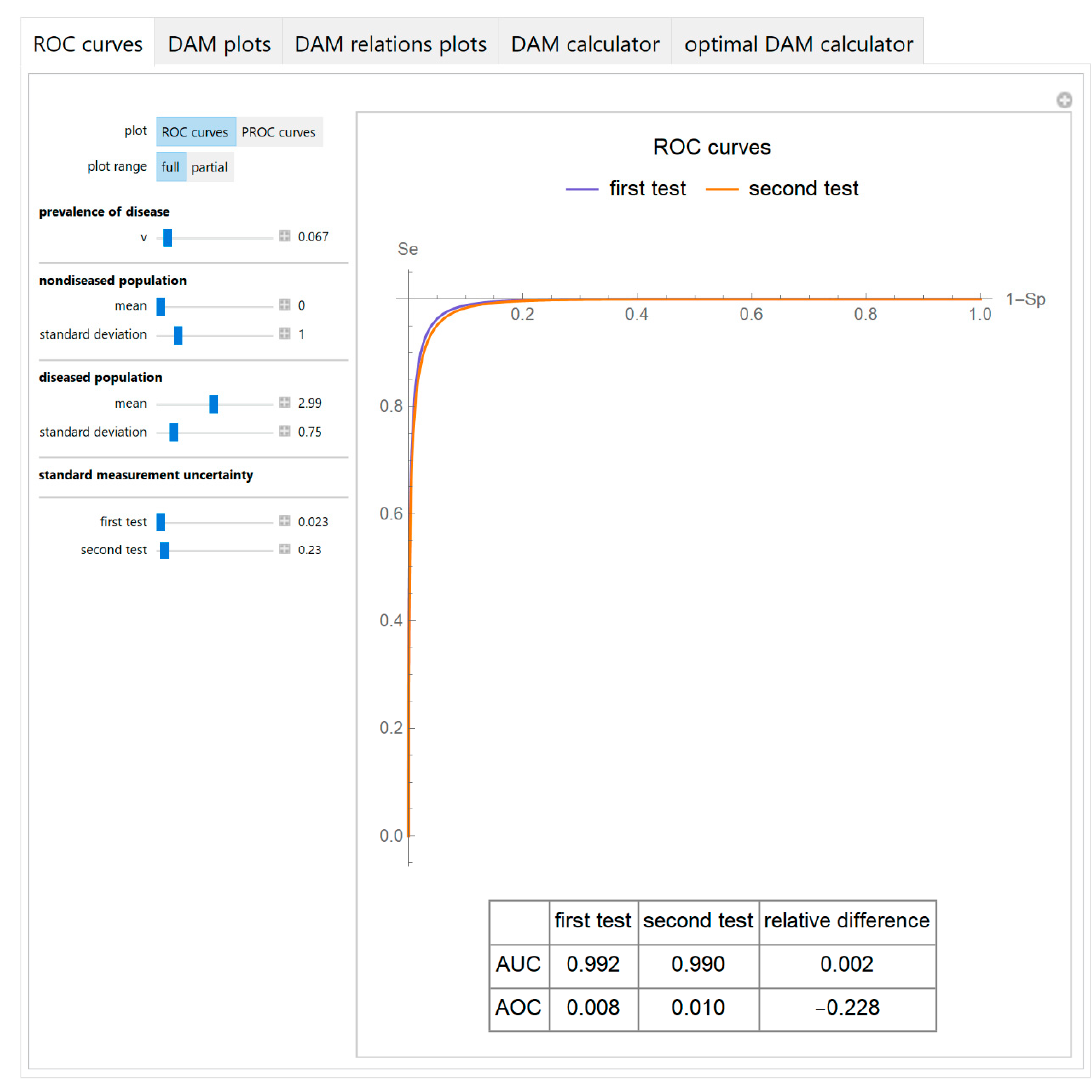
Figure 3. ROC curves module screenshot. ROC curves plots of two screening or diagnostic tests measuring the same measurand with different uncertainties, with the settings at the left.